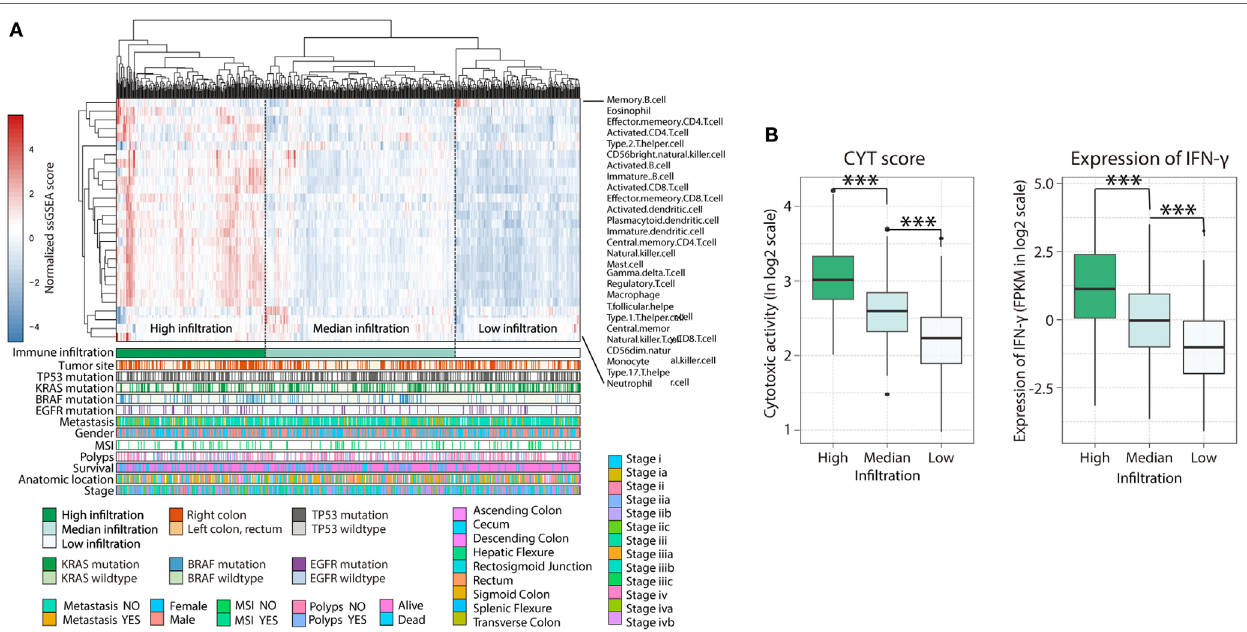
FigUre 1 | Immune landscape of colorectal cancer. (a) Unsupervised clustering of 638 patients from the The Cancer Genome Atlas cohort using single-sample gene set enrichment analysis scores from 27 immune cell types. Primary tumor location, mutation status of EGFR , BRAF , KRAS , and TP53, metastasis, gender, MSI, polyps, survival, anatomic location, as well as stage were annotated in the lower panel. Hierarchical clustering was performed with Euclidean distance and Ward linkage. Three distinct immune infiltration clusters, here termed high infiltration, median infiltration, and low infiltration, were defined. (B) Relative cytolytic score (CYT) and expression of IFN- γ between immune infiltration high, median, and low tumors clustered by overall immune cell infiltration. Two-tailed Student’s t -tests were used for all analyses. Error bars represent the mean ± SEM. * p < 0.05; ** p < 0.01; *** p < 0.001; p ≥ 0.05, not